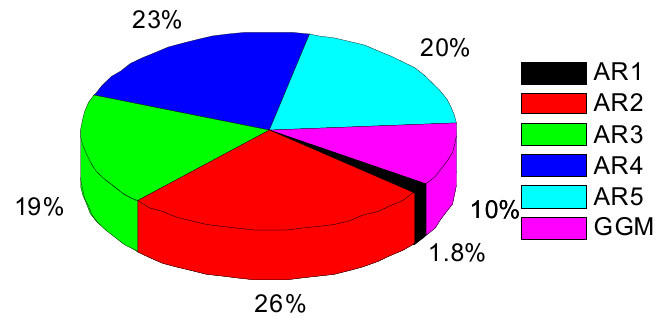
Figure 5. The percentage of noise models in Figure 4.